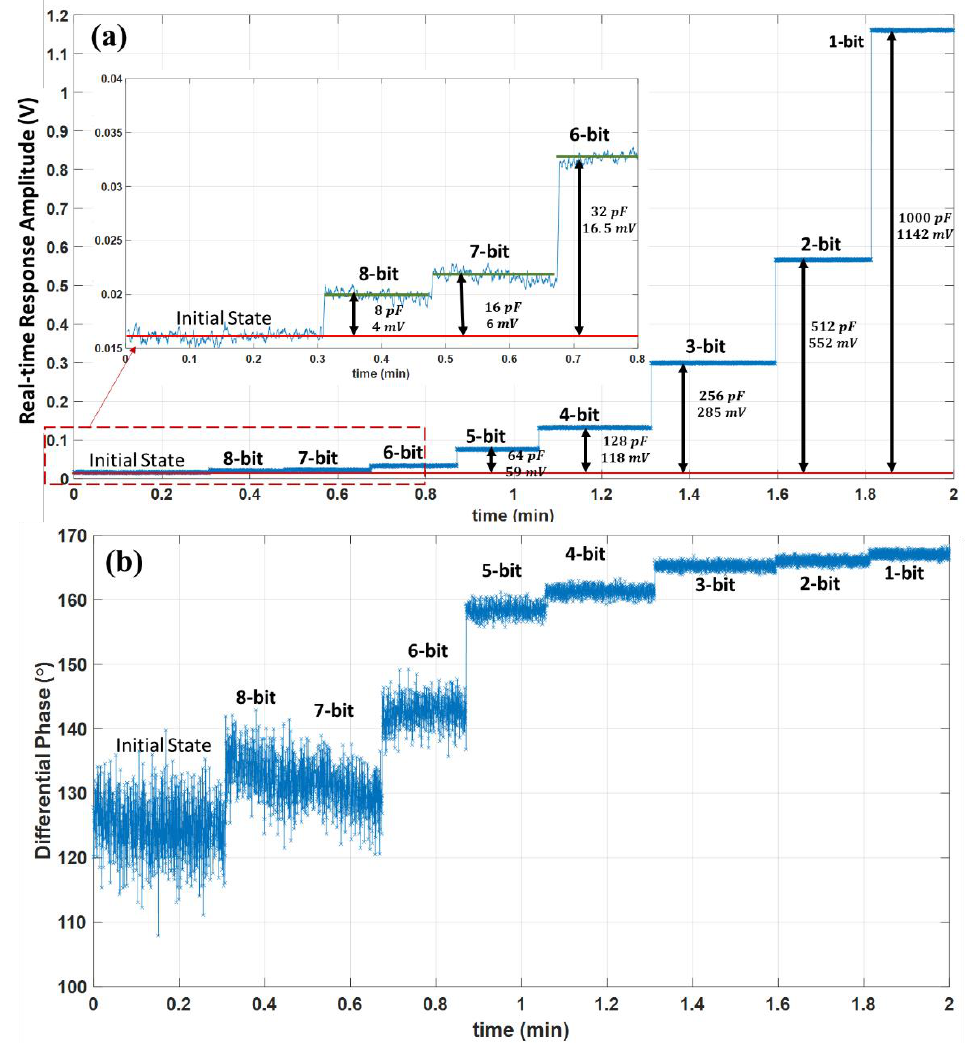
Figure 12. Sensitivity to 1% capacitance change with 8-bit resolution and real-time processing verification for the implementation of the readout board. The obtained amplitude from the real- time 3PSF for 8 pF, 16 pF, 32 pF, 64 pF, 128 pF, 256 pF, 512 pF and 1 nF capacitance change at a symmetrical impedance bridge with a fixed capacitance of 100 nF; ( a ). the obtained real-time differential phase and the corresponding amplitude can be used to compute actual capacitance change for a known bridge impedance model ( b